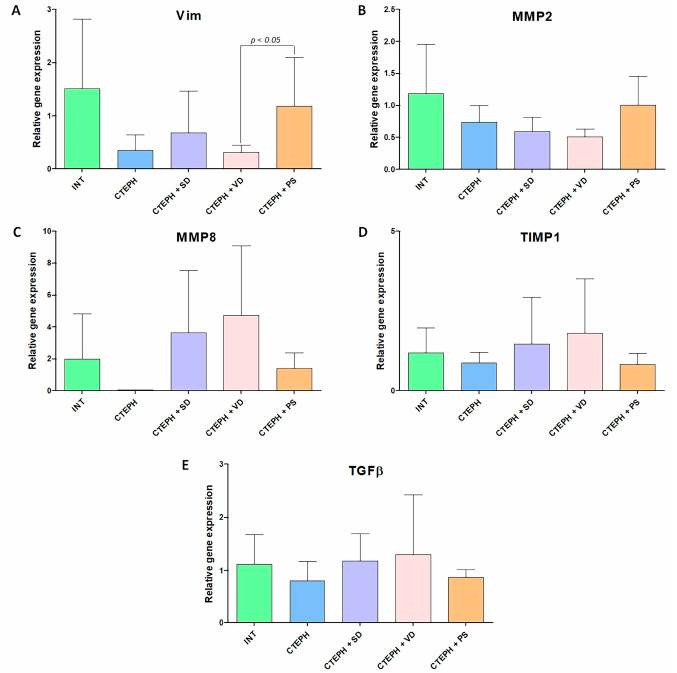
Figure 6. Analysis of expression of profibrotic factors in myocardial tissue with different variants of activity of vegetative nervous system. (A) —relative gene expression of Vim, (B) —relative gene ex- pression of MMP2, (C) —relative gene expression of MMP8, (D) —relative gene expression of TIMP1, (E) —relative gene expression of TGF β . INT—intact animals (n = 8), CTEPH—chronic throm- boembolic pulmonary hypertension (n = 5), CTEPH + SD—CTEPH + sympathetic denervation (n = 8), CTEPH + VD—CTEPH + vagus denervation (n = 6), CTEPH + PS—CTEPH + pyridostigmine (n = 5). Vim—vimentin, MMP2—matrix metalloproteinase-2, MMP8—matrix metalloproteinase-8, TIMP1—tissue inhibitor of metalloprotease-1, TGF β —transforming growth factor beta.